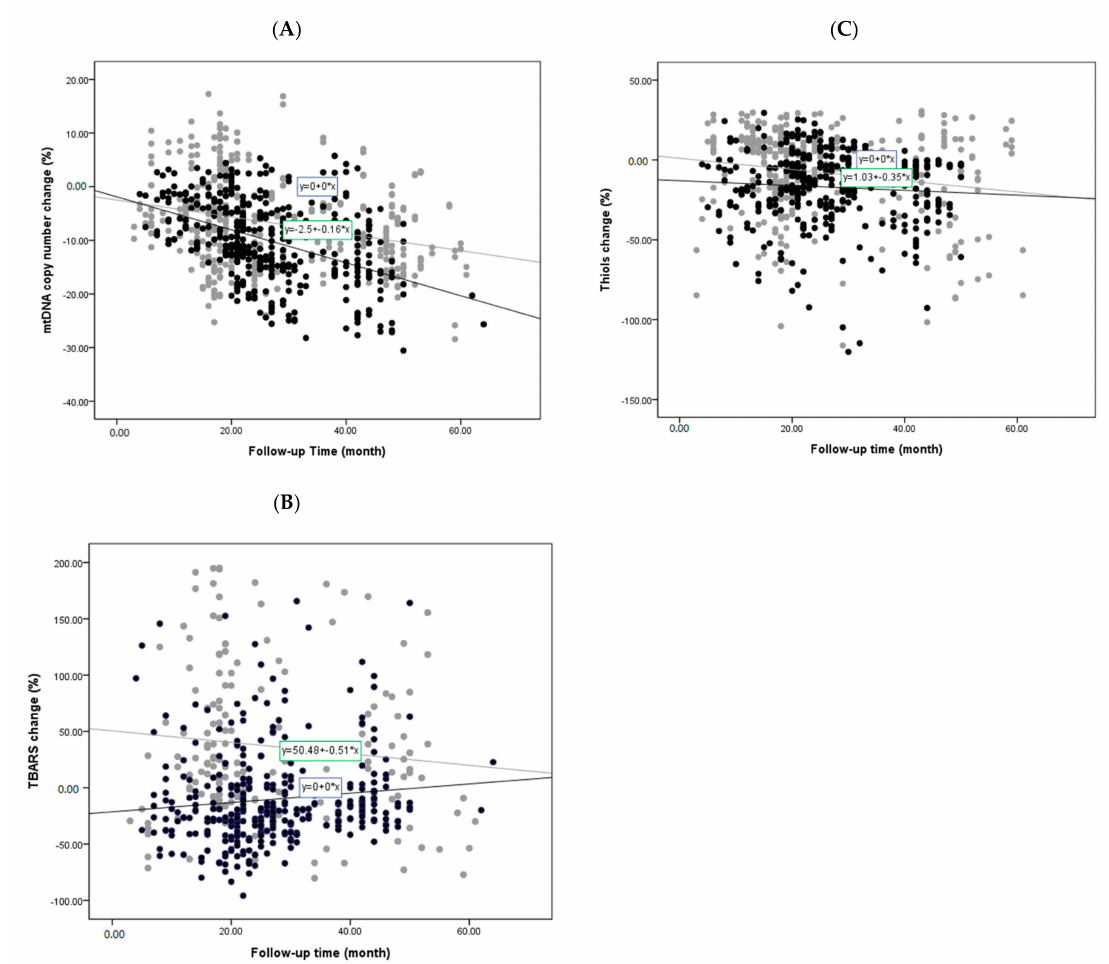
Figure 2. Changes of oxidative stress markers and mtDNA copy number during follow-up studies of PD patients and non-PD controls: Simple scatter plots show changes of Log ∆ Ct copy number ( A ), TBARS ( B ), and thiols ( C ) during follow-up studies of PD patients and non-PD controls. ( • in ( A – C ) represents PD patient group; • in ( A – C ) represents non-PD control